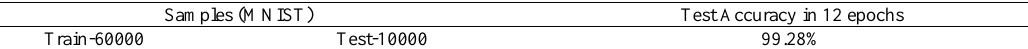
Table 6. Performance of model for MNIST dataset